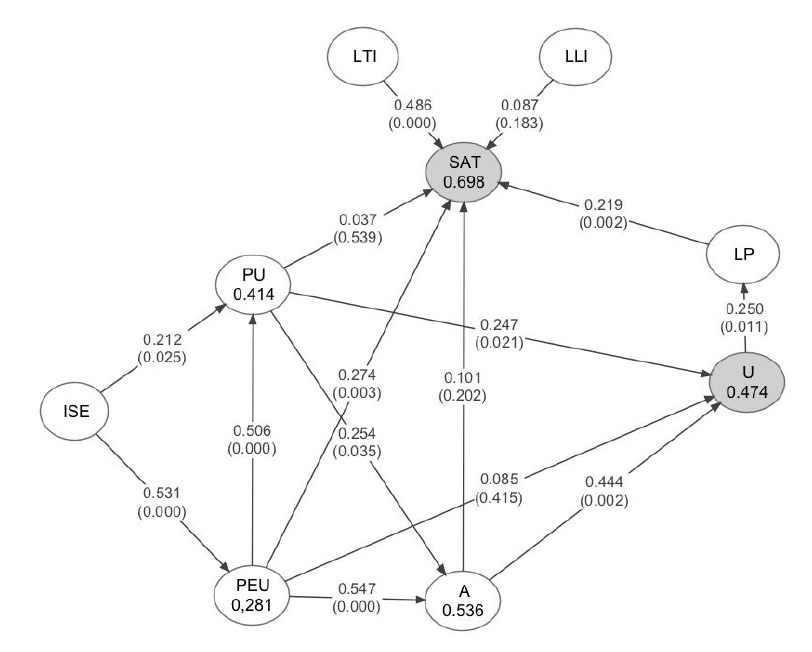
Figure 3. The results of partial least squares